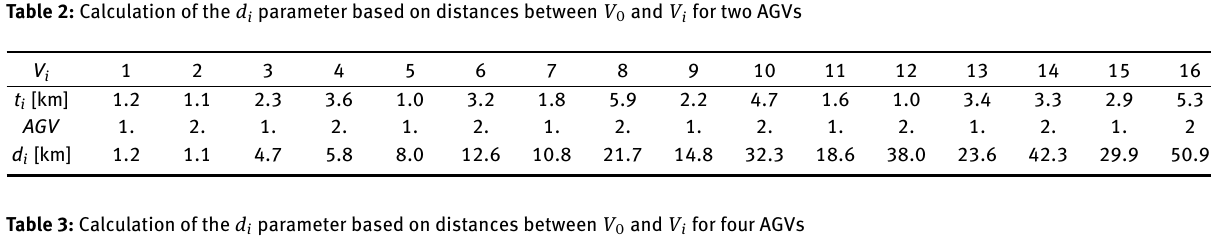
Table 3: Calculation of the d i parameter based on distances between V 0 and V i for four AGVs V i 1 AGV